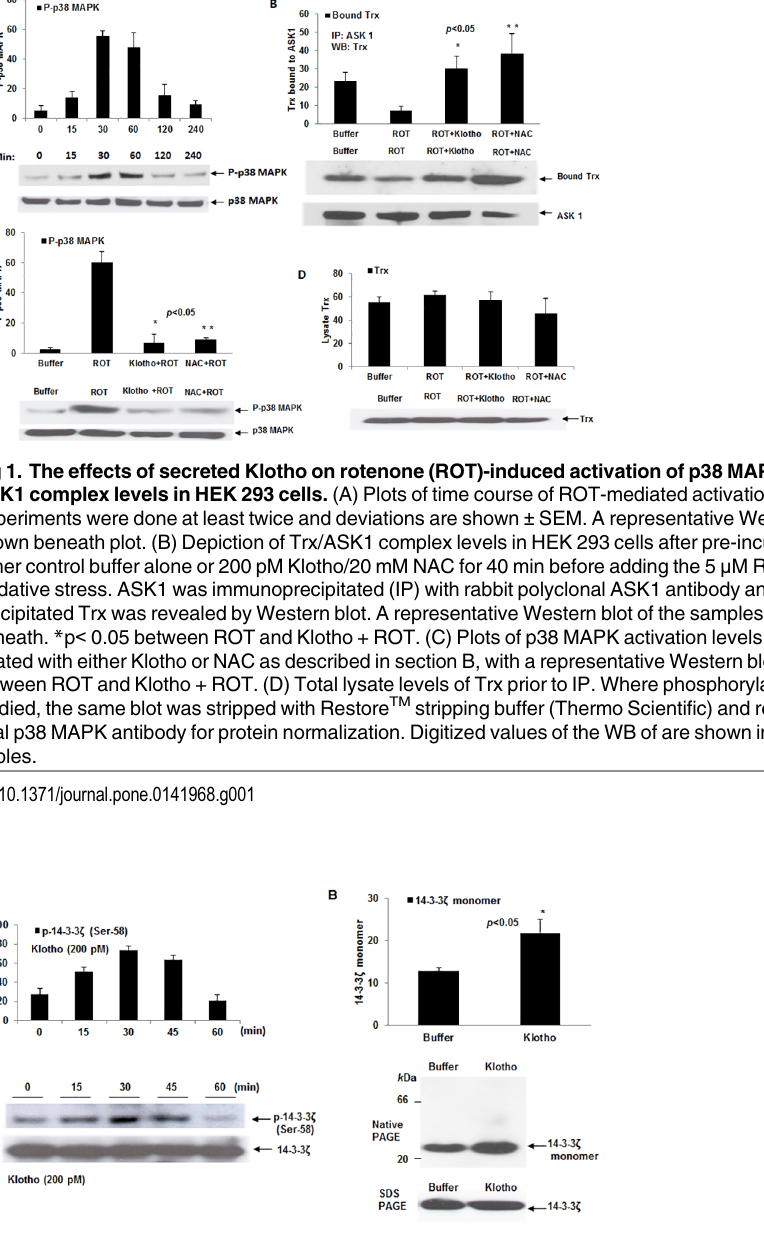
Fig 2. Time course of Klotho-mediated phosphorylation of endogenous 14-3-3 ζ (Ser-58) effect on 14- 3-3 ζ monomer levels in HEK 293 cells. (A) Plot describing time-dependent 14-3-3 ζ phosphorylation mediated by Klotho was demonstrated by adding 200 pM of the recombinant protein to the cultured cells at the indicated times. Peak phosphorylation times (i.e. 30 – 45 min) are within the range where the Trx/ASK1 complex protection against oxidative stress occurred (Fig 1). Data are reported as ± SEM. (B) Plot of 14-3-3 ζ monomer level in HEK 293 cells treated with either secreted Klotho or buffer control for 40 min. Shown beside plot is a native Western blot of the samples as described in Materials and Methods. The 14-3-3 ζ antibody recognizes a predominant ~30 k Da protein band representing the expected size of the monomer. Replicate samples were separated under SDS-PAGE, electroblotted onto PVDF membrane and probed with same antibody to account for lysate levels of total 14-3-3 ζ . Digitized values of the WB of monomer levels are shown in S3